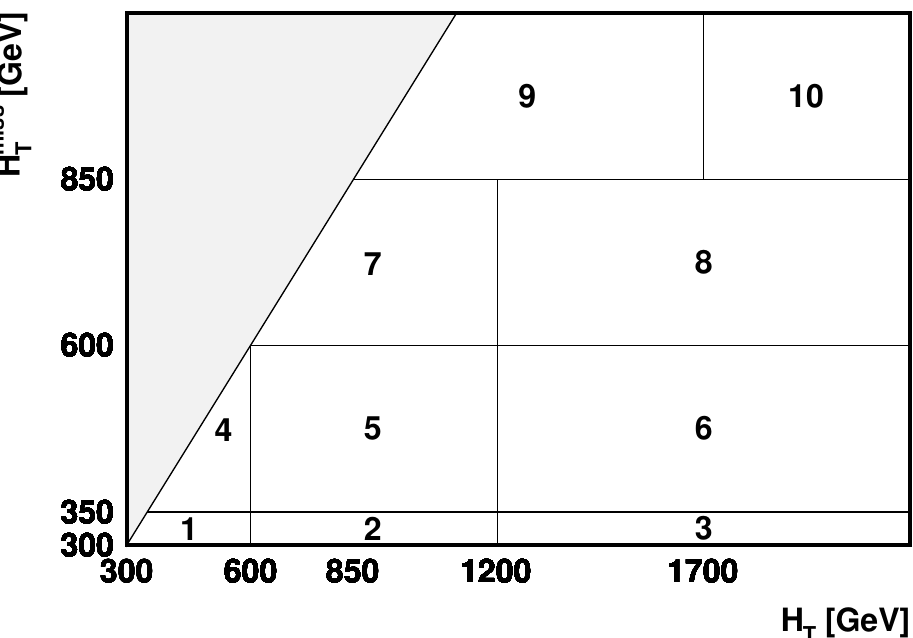
Figure 3 . Schematic illustration of the 10 kinematic search intervals in the H miss versus H T T plane. The diagonal line delineating the leftmost edge of regions 1, 4, 7, and 9 corresponds to the restriction H miss < H . Regions 1 and 4 are excluded for N (cid:21) 8. The rightmost and topmost T T jet bins are unbounded, extending to H = 1 and H miss = 1 , T T